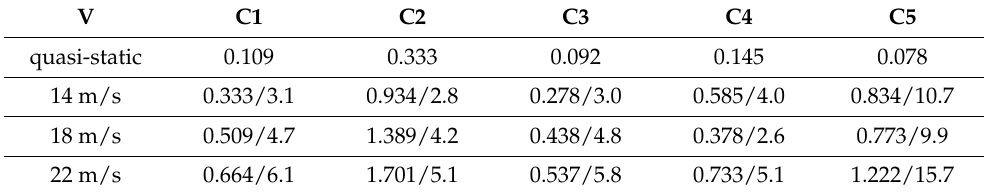
Figure 8. Energy absorption curves of different specimens at different impact velocities. ( a ) v0 = 14 m/s, ( b ) v0 = 18 m/s, ( c ) v0 = 22 m/s. Table 3. Comparison of the energy absorption (J/cm 3 ) of the specimens under SHPB tests and quasi-static compression